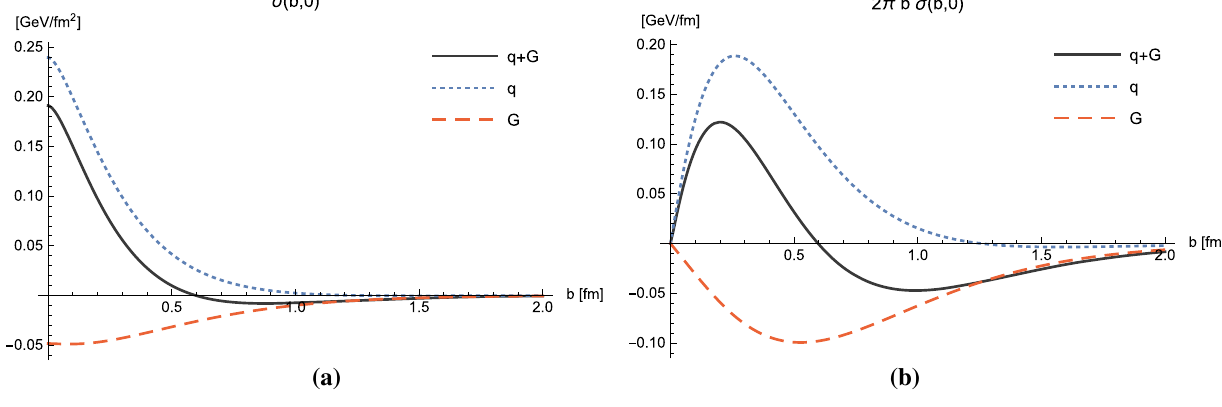
Fig. 14 Plots of the two-dimensional isotropic pressure, a σ( b , 0 ) and b 2 π b σ( b , 0 ) , using the multipole model (11) with parameters given in Table 1, see Eq. (59) or (64) for the definition in terms of